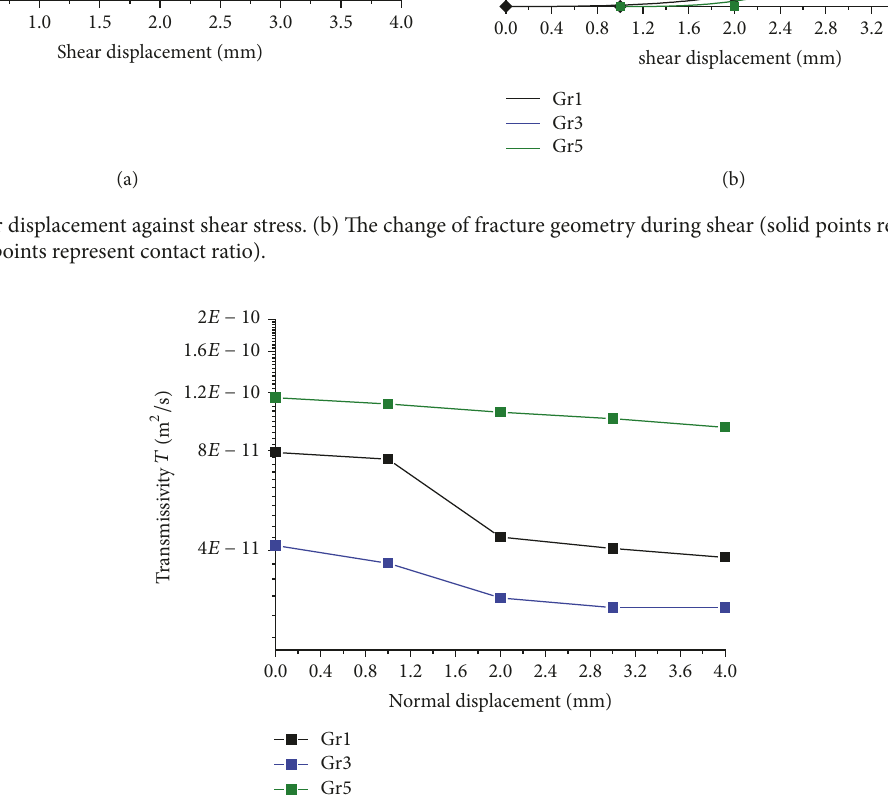
Figure 11: The relationship of transmissivity between shear displacements in different